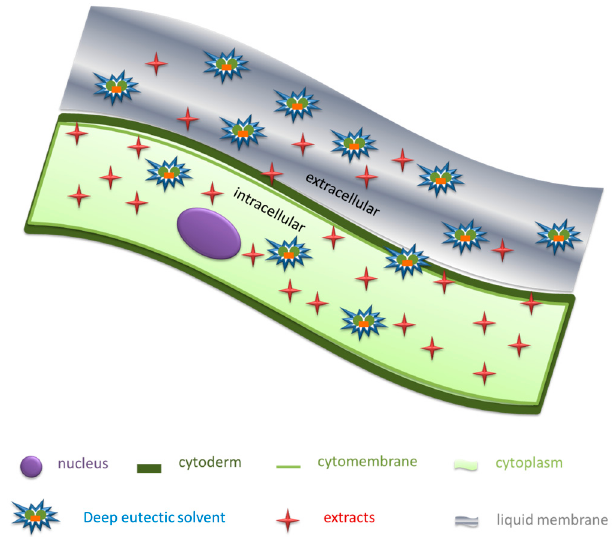
Figure 5. Unstable and non-equilibrium diffusion model of release of target components from plant cells.